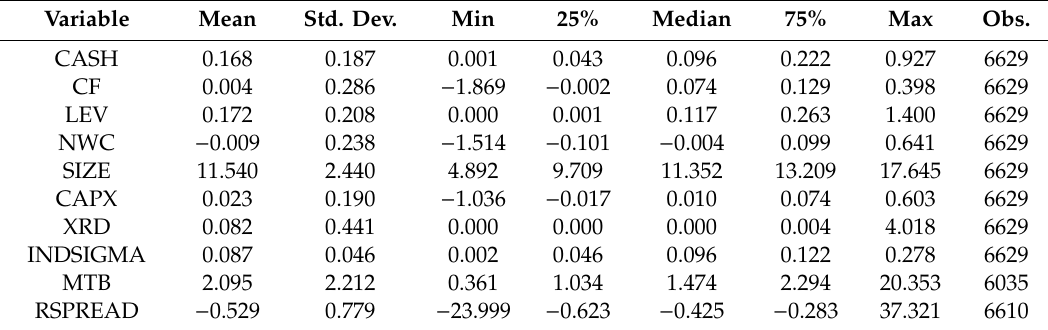
Table 3. Summary statistics for key variables.